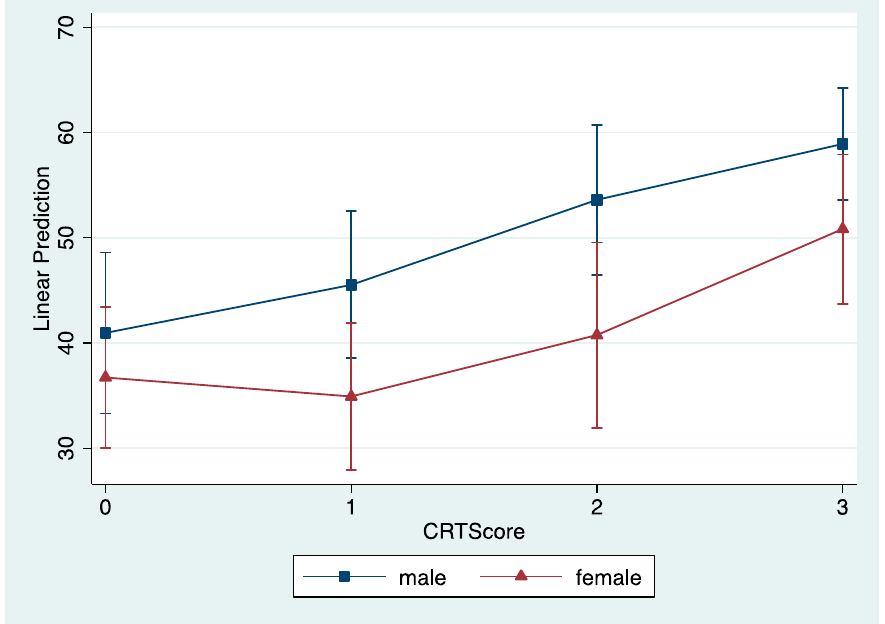
Figure 2. Predictive values (max = 100) for total score controlling for CRT score and